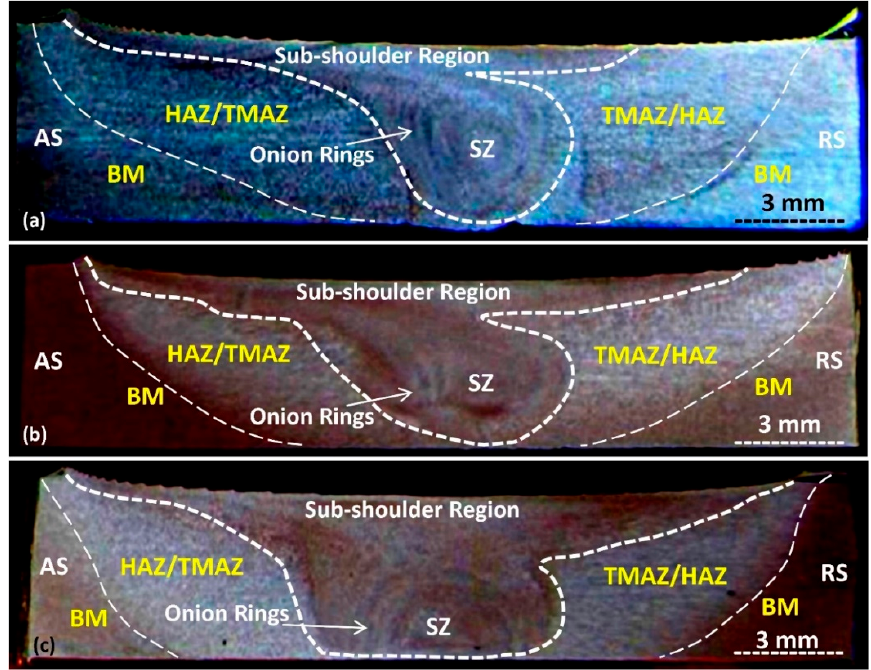
Figure 7. The macrostructure of the cross-section of the FSW weld for three different tools: ( a ) conical, ( b ) square and ( c ) threaded; all in speeds of 250 mm/min and 1400 rpm.